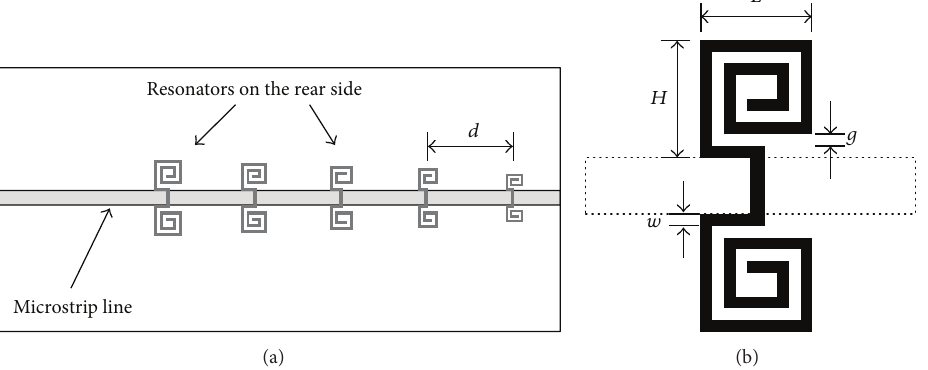
Figure 1: Layout of the multiple resonator circuit using defected ground structures. (a) Multiple resonator circuits. (b) Spiral-shaped DGS